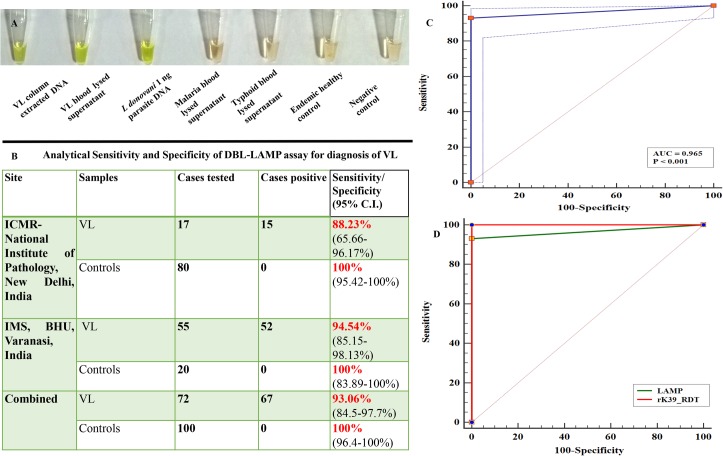
Simplified Direct Blood Lysis (DBL)-LAMP assay for diagnosis of VL.(A)- Visual appearance of amplified product on addition of diluted SYBR Green I for LAMP and DBL-LAMP assay at the end of reaction. The DBL-LAMP assay was performed using direct blood lysed supernatant instead of column extracted DNA; as described in the methods section. Negative samples remained orange whereas positives turned instantly green on giving brief spin allowing mixing of SYBR Green I (1:10 diluted) at the end of the reaction. (B)- Analytical sensitivity and specificity of DBL-LAMP assay for diagnosis of VL. (C)-ROC curve for DBL-LAMP assay for diagnosis of VL. The AUCROC for DBL-LAMP assay was 0.965; p<0.0001 indicative of an excellent diagnostic test. (D)- Comparative ROC curve analysis for DBL-LAMP assay vs rK39 RDT. The AUCROCs for rK39 RDT and DBL-LAMP were 1.00 and 0.965 respectively. No remarkable difference between the AUCROCs 0.0347(SE 0.0176, p-1.971).